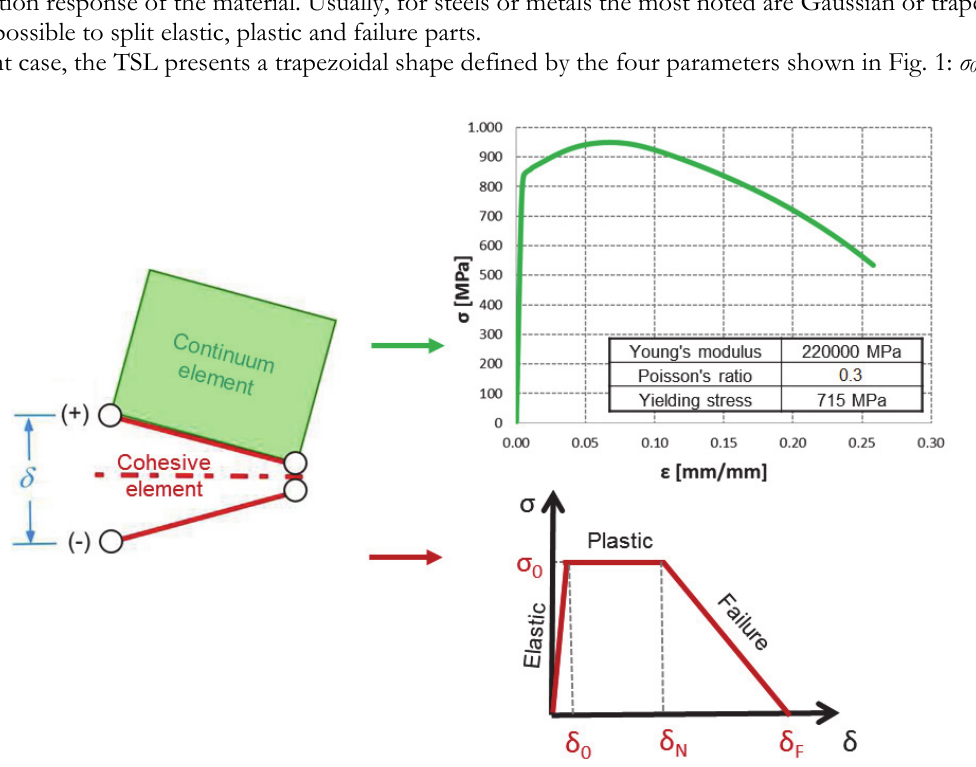
Figure 1: Experimental tensile curve and values of mechanical parameters used for continuum elements. TSL shape as stress- displacement